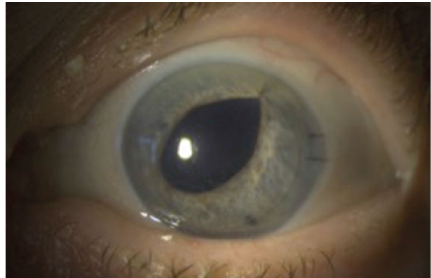
Figure 3: Slit lamp photograph of the left eye with di ff use light one